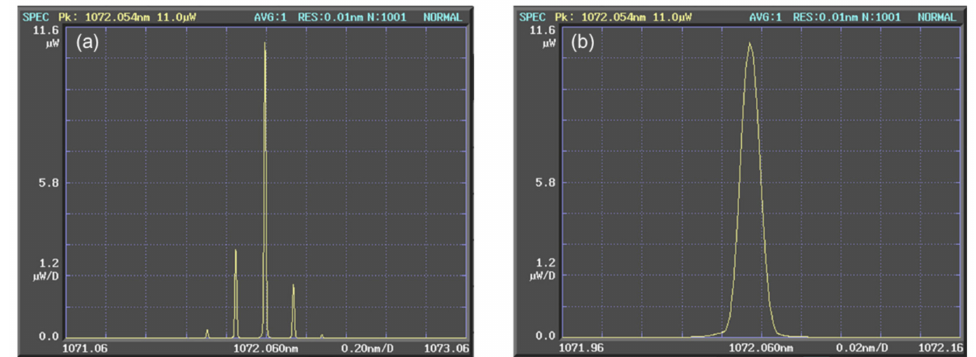
Figure 5. ( a ) Five-wavelength generation based on four-wave mixing (0.20 nm/div). ( b ) Enlarged view of only one wavelength, showing longitudinal single-mode oscillation. The vertical axes in ( a , b ) are a linear scale.